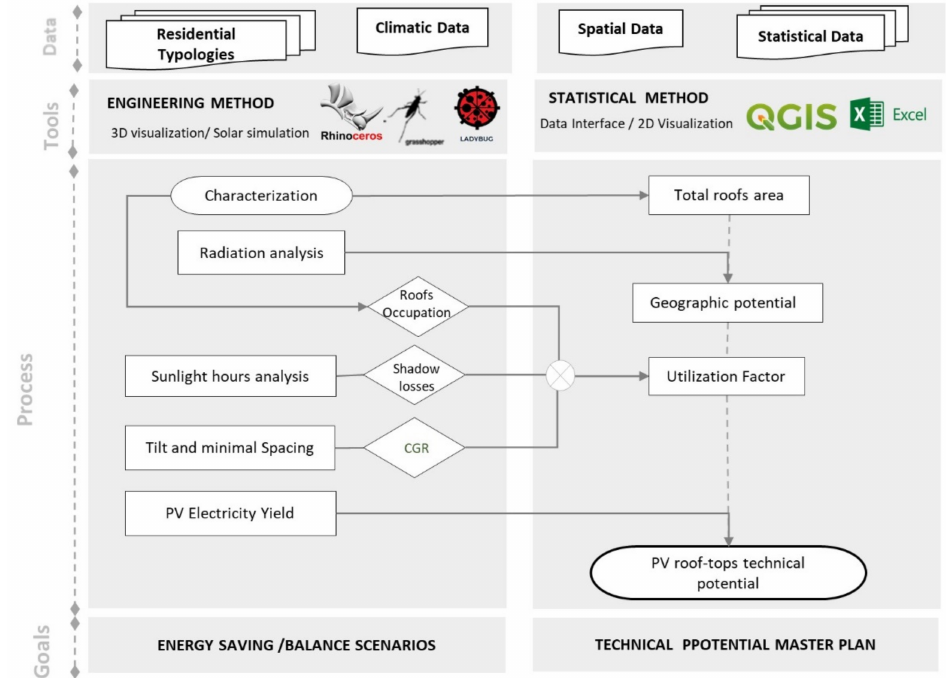
Figure 1. Flowchart of the proposed methodology for solar potential